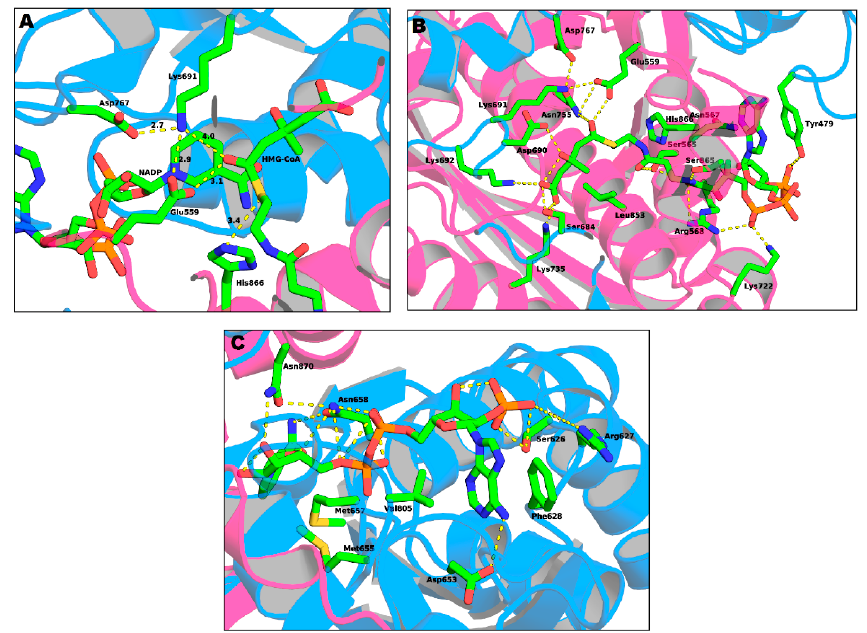
Figure 10. Representation of: ( A ) the active site of HMG-CoAR; ( B ) the binding sites of the HMG portion of HMG-CoA; and ( C ) the binding sites of NADP (PDB entry 1DQ9). The NADPH (Figure 10C) binds to the S-domain of the opposing subunit in which the HMG- CoA binding pocket is located. Residues Ser626, Arg627, Phe628, Asp653, Met655, Gly656, Met657, Asn658 and Val805 come from the S-domain and residues Asn870 and Arg871 from the neighboring monomer. In the presence of NADPH, a conformational change in the C-terminus of the enzyme is observed which leads to the closure of the active site [49].